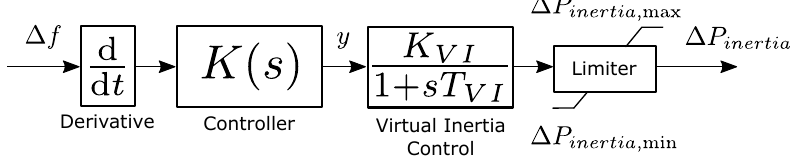
Figure 3. Typical structure of a virtual inertia control